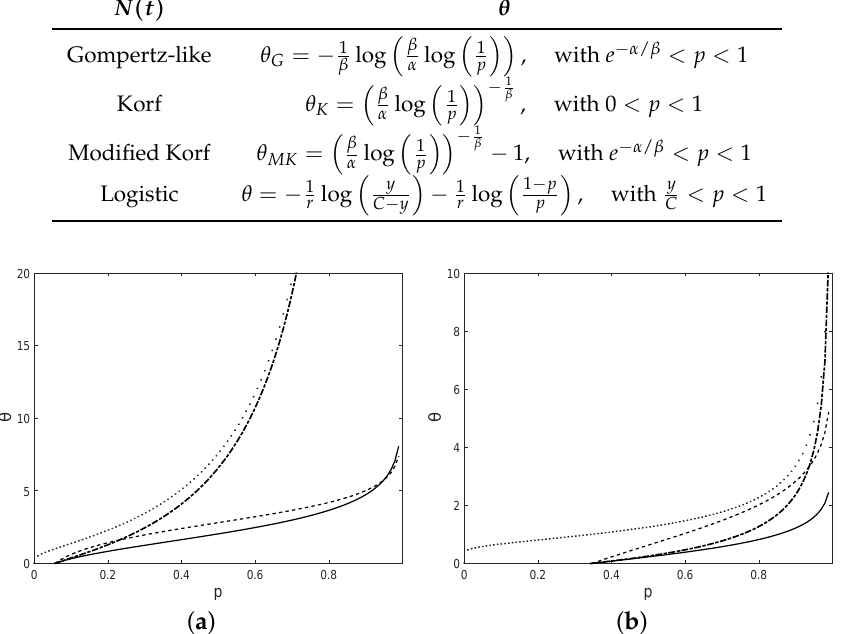
Table 5. The threshold crossing times for the considered growth models.